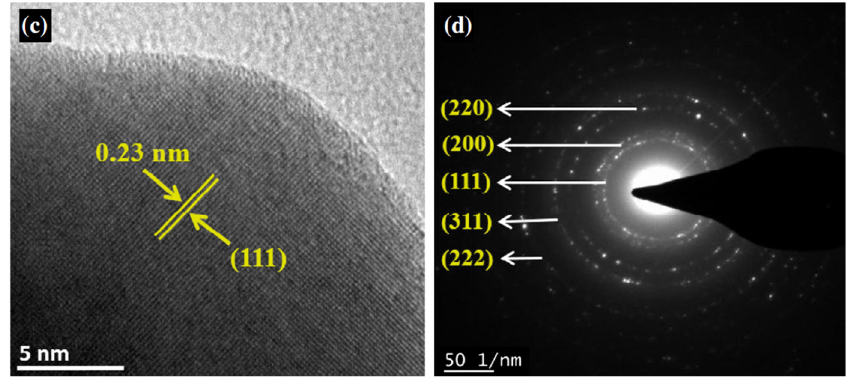
Figure 4. TEM images of AgNPs formed at ( a ) pH 6, and ( b ) pH 12. ( c ) High-resolution TEM image and ( d ) selected area electron diffraction pattern of AgNP. Reproduced from [82] with permission of Elsevier.